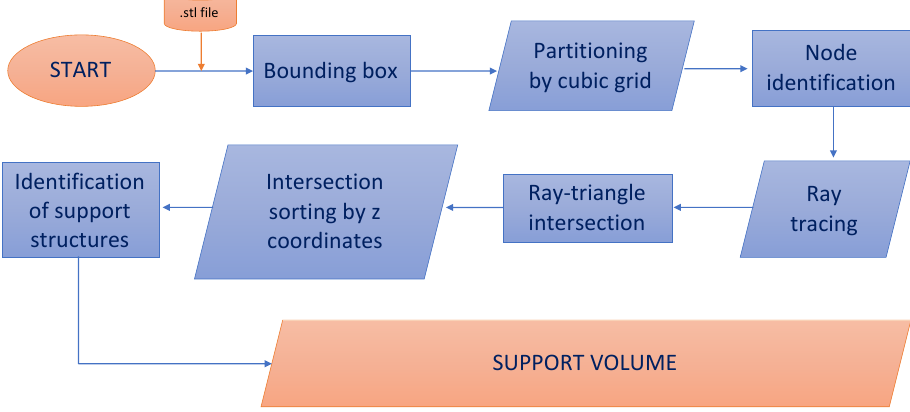
Figure 9. Flowchart of the voxelization algorithm proposed by